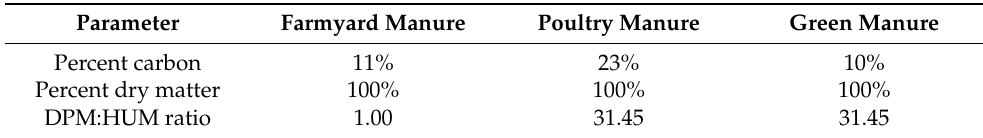
Table 5. Organic manure parameters used in the simulations. Note: DPM = decomposable plant material; HUM = humus (recalcitrant plant material).